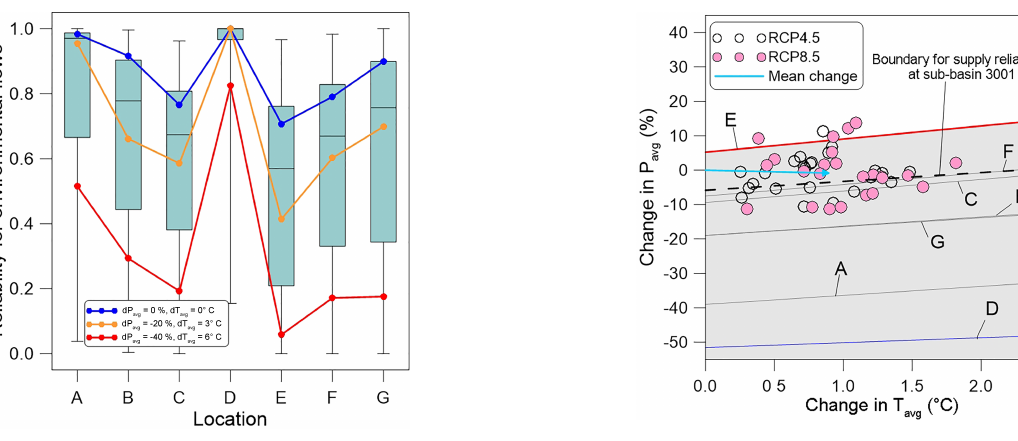
Figure 6. As in Fig. 4, but for the probability of ρ e > 0 . 70 at the seven locations of instream